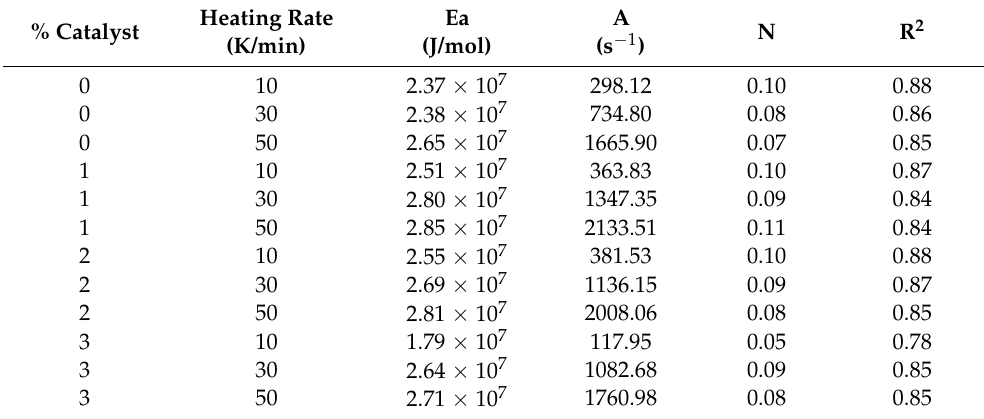
Table 4. Kinetic results n-reaction order